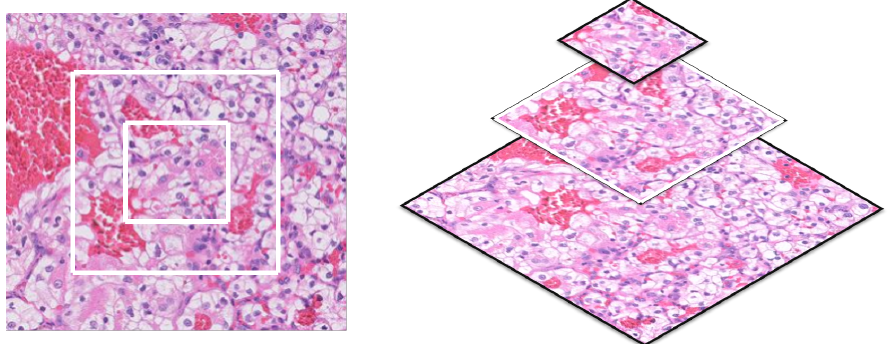
Figure 8. Tiling, extracting concentric patches of test subjects’